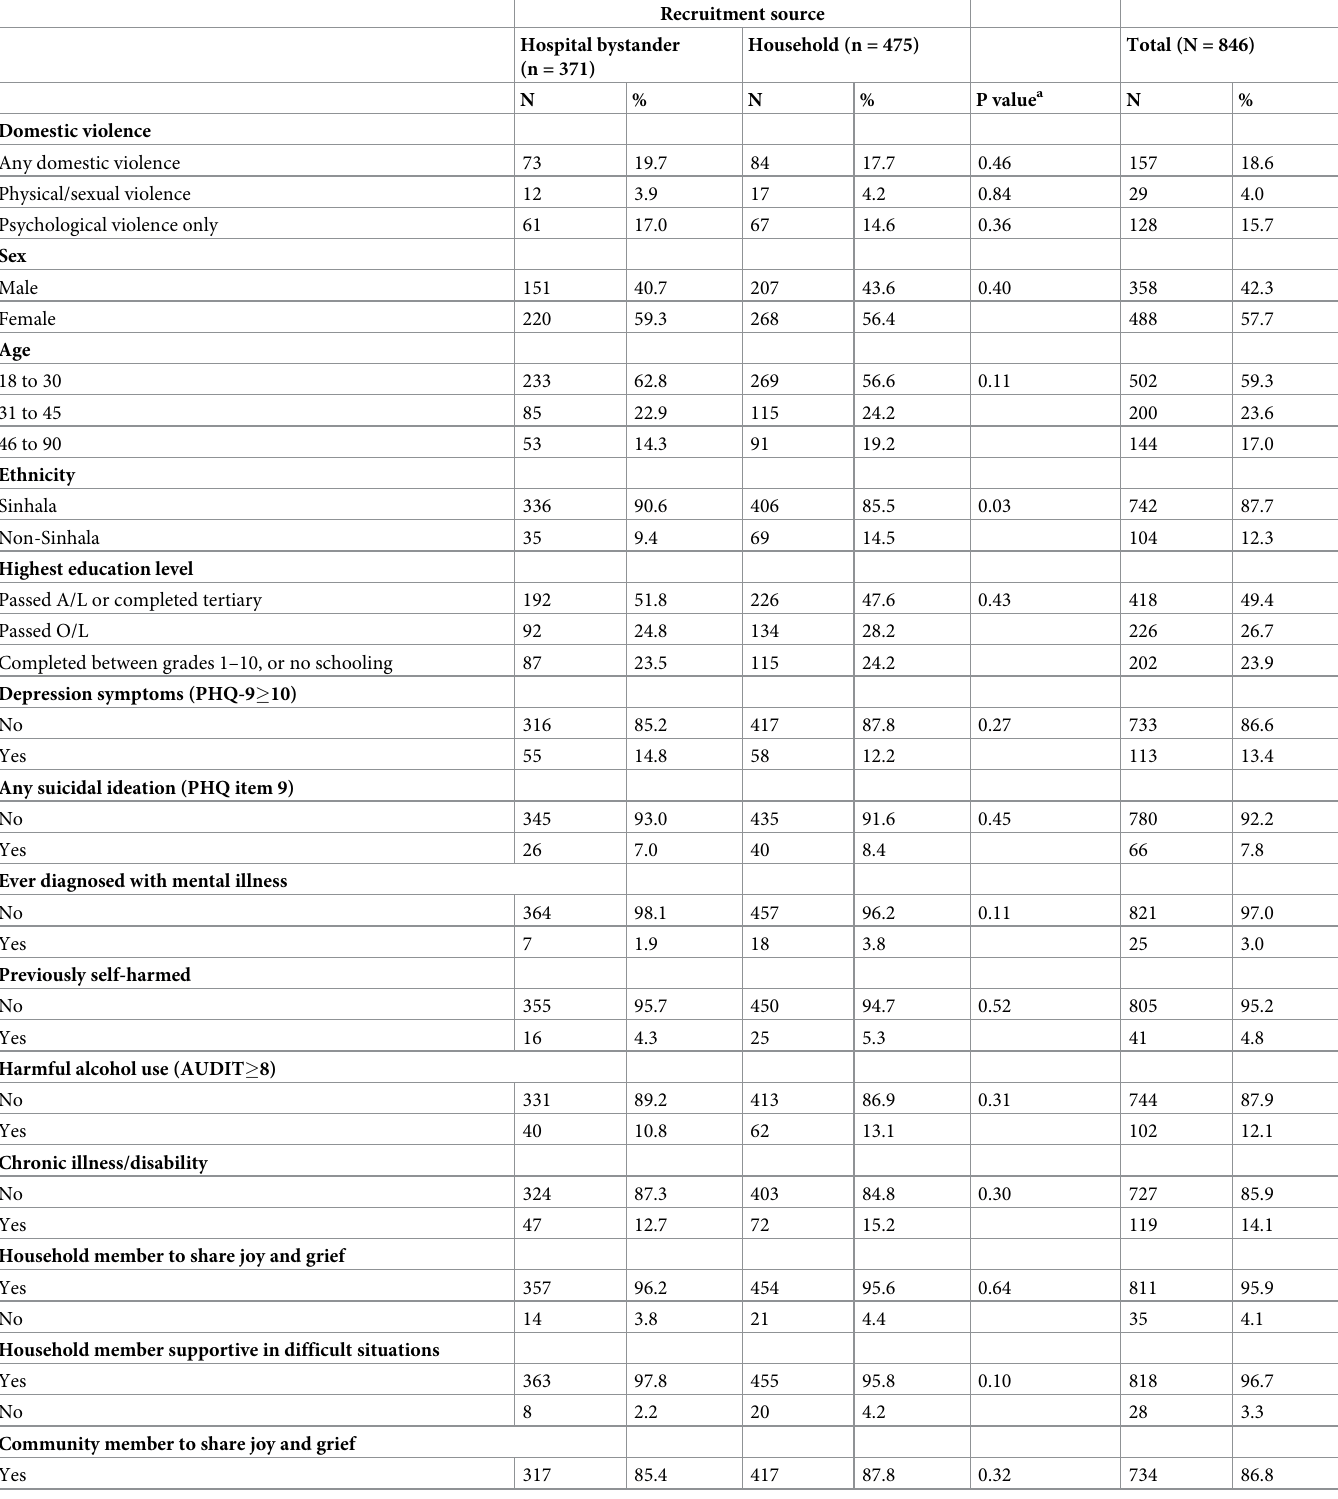
Table 1. Distribution of study characteristics by recruitment source and